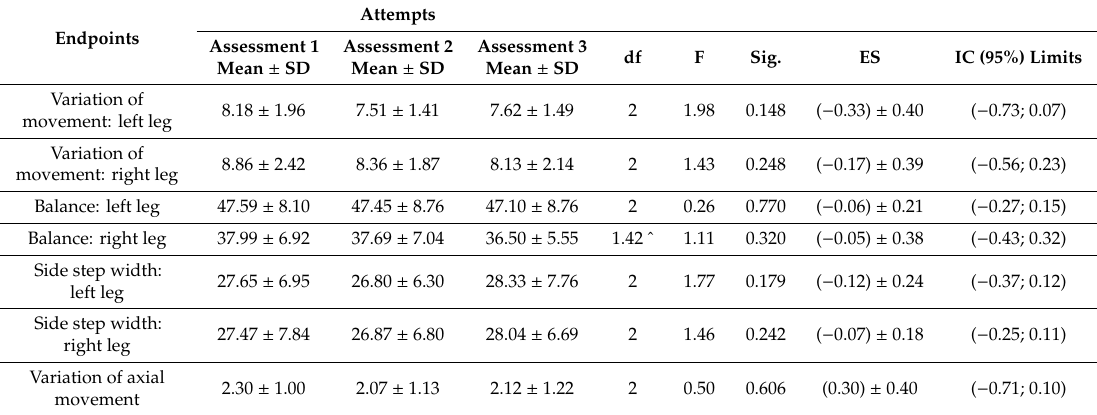
Table 4. The average di ff erence between attempts—lower